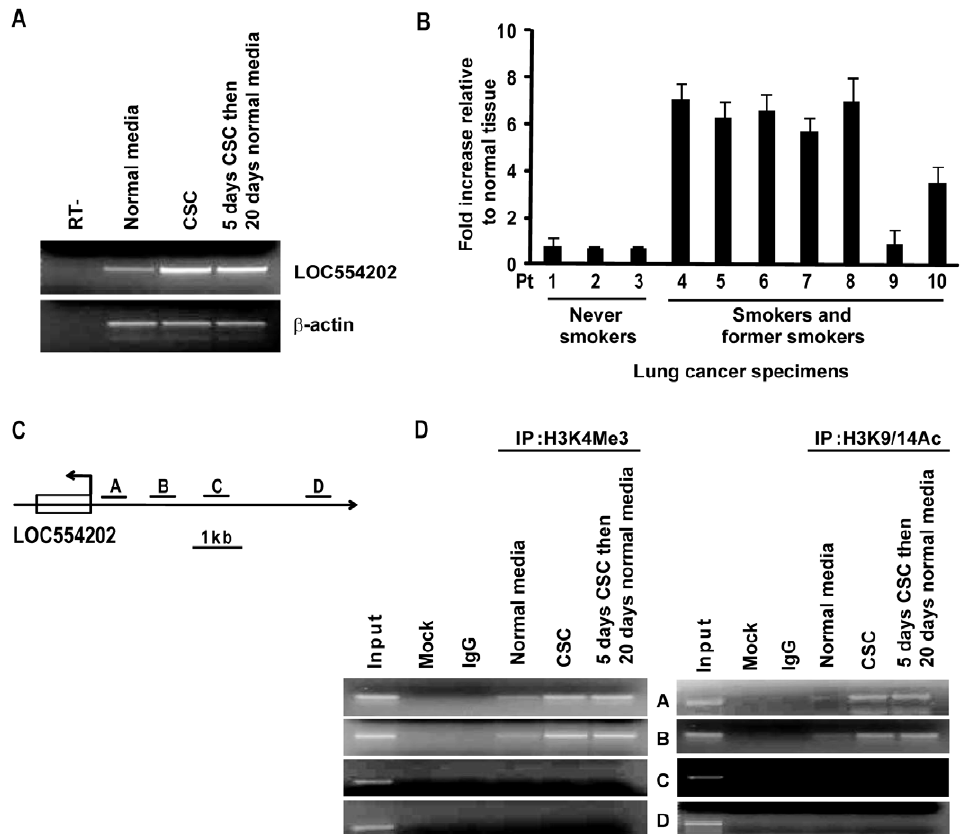
Figure 4. Epigenetic alterations coinciding with CSC-mediated activation of miR-31. A) RT-PCR analysis demonstrating up-regulation of LOC554202 expression in SAEC following 5-day CSC exposure. Consistent with data pertaining to up-regulation of miR-31 by CSC, expression of LOC554202 persisted for 20 days following cessation of CSC exposure. B) qRT-PCR analysis demonstrating expression levels of LOC554202 in primary lung cancers relative to adjacent normal lung tissues. C) Schematic representation of LOC554202, the putative host gene of miR-31. A, B, C, and D represent positions of paired primers used for ChIP analysis. D) ChIP analysis depicting H3K4Me3 and H3K9/14 acetylation levels within four regions of the LOC554202 promoter ( , 1 kb, 2 kb, 3 kb, and, 5 kb from the TSS) in SAEC cultured with or without CSC. Increased activation marks were observed in the proximal promoter region following CSC exposure.